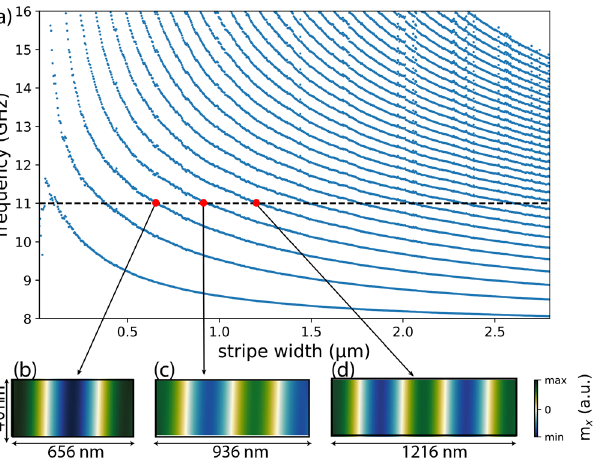
Figure 3. ( a ) Dependence of the frequency of stripe modes on the stripe width. The dashed line marks the frequency f = 11 GHz. ( b – d ) Profiles of modes supported by stripes of width 656 nm, 936 nm, and 1216 nm at frequency 11